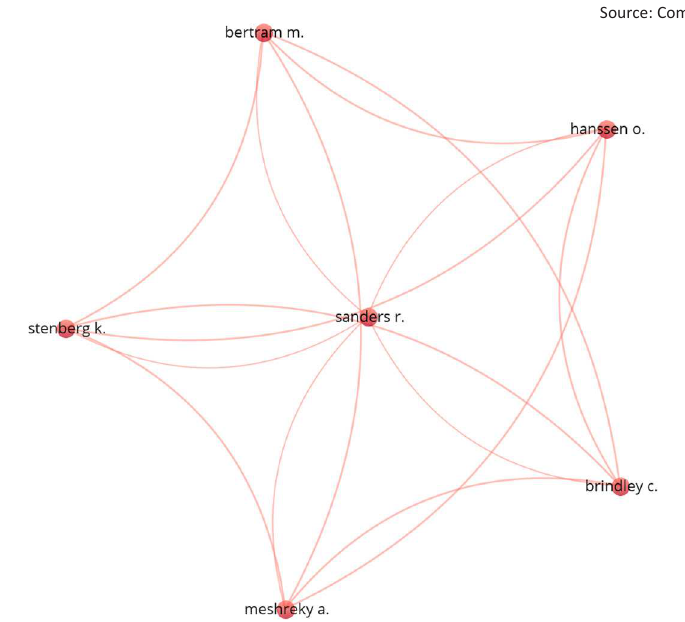
Figure 4. Bibliometric map of publications concerning “SDG 3 and investment” and “SDG 3 and responsible investment” by